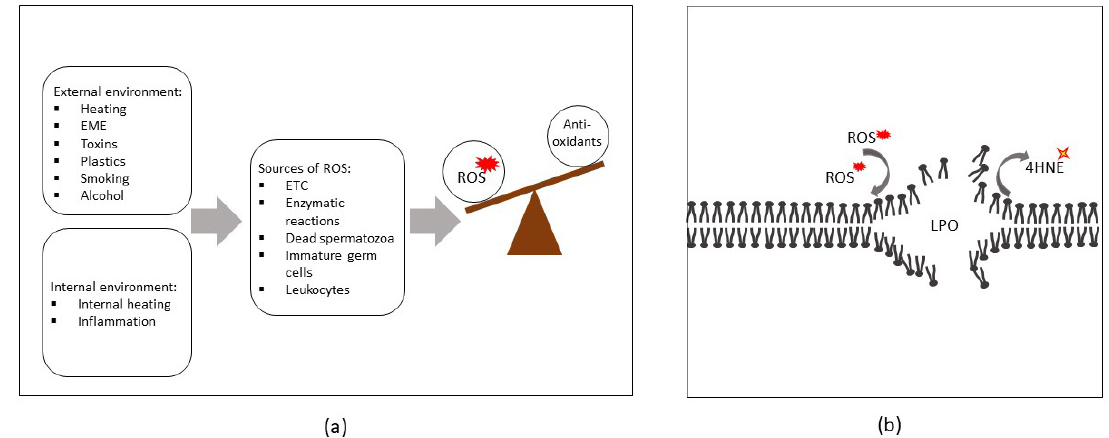
Figure 1. ( a ) Sources of reactive oxygen species (ROS) in human spermatozoa and the relationship between the rate of their production and antioxidant defenses during oxidative stress. ( b ) ROS are capable of attacking polyunsaturated fatty acids (PUFAs) within cellular membranes, initiating lipid peroxidation cascades (LPO) and resulting in the production of cytotoxic lipid aldehydes such as 4-hydroxynonenal (4HNE). Abbreviations: EME, electromagnetic energy; ETC, electron transport chain.